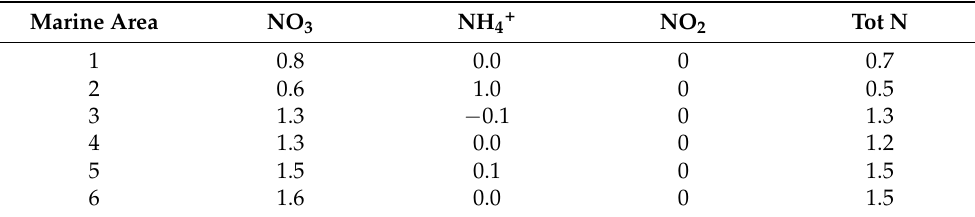
Table 6. Percentage change between baseline and scenario in nitrogen load to the six marine areas (shown in Figure 2).